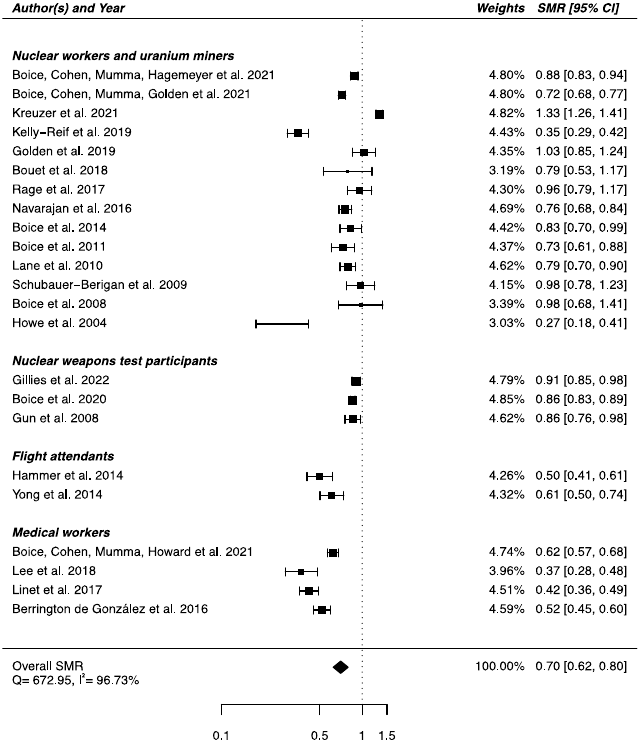
Figure 6. Standardized mortality ratio (SMR) and 95% confidence interval (CI) for mortality from cerebrovascular diseases in IR exposed populations compared with general populations as refer- ence.